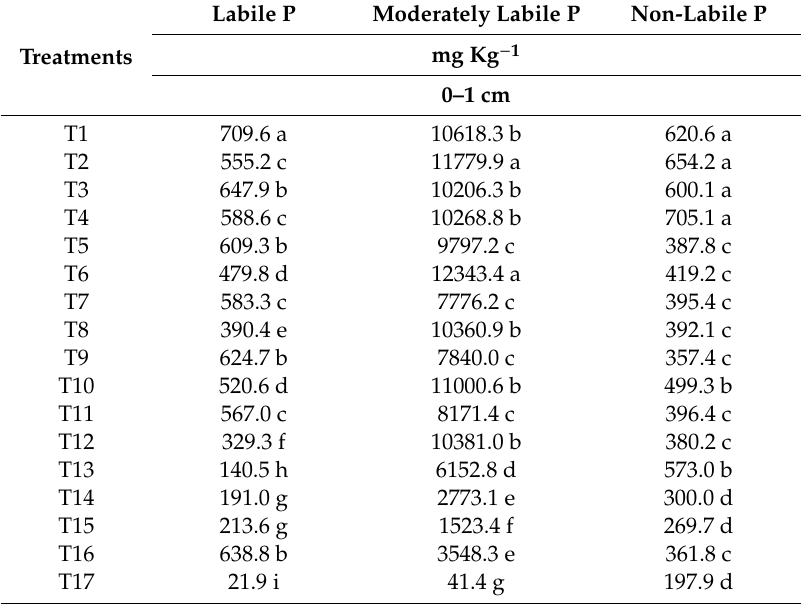
Table A1. Labile, moderately labile and non-labile P pools in the surface soil layer of the column in response to phosphate fertilizer application after 60